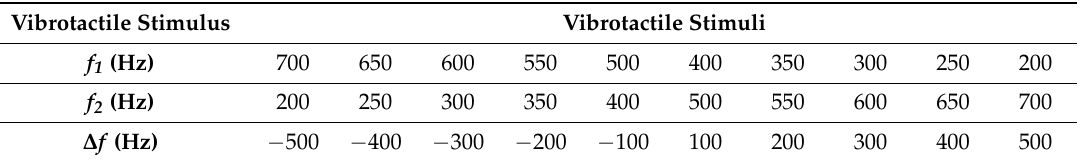
Figure 5. Stimulation and task. ( a ) An example of a pair of stimuli: 250 ms of sinusoidal oscillations with a frequency of 200 Hz followed by 250 ms sinusoidal oscillation with a frequency of 700 Hz. The peak-to-peak amplitude activating the transducer was fixed at 150 V; ( b ) a 0.04 s slice of the vibrotactile stimulation shown in panel ( a ), depicting the frequency transition at 0.25 s; and ( c ) the participant decision phase: after perceiving the vibrotactile stimuli pair, the participant was asked to determine whether the first or the second had the higher frequency content. Table 1. Experimental stimulation parameters. Ten pairs of vibrotactile stimuli. First vibrotactile stimulus: f 1 ; second vibrotactile stimulus: f 2 ; and related frequency variation ∆ f = f 2 − f 1 .